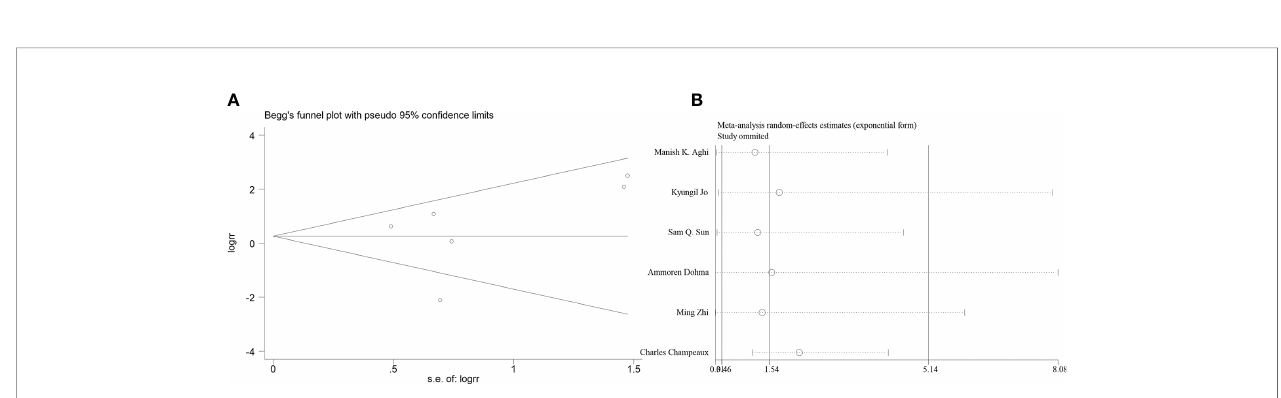
FIGURE 4 | (A) Begg ’ s funnel plots of publication bias for meta-analysis of PORT on 5-year LC before excluding. (B) Sensitivity analysis for meta-analysis of PORT.